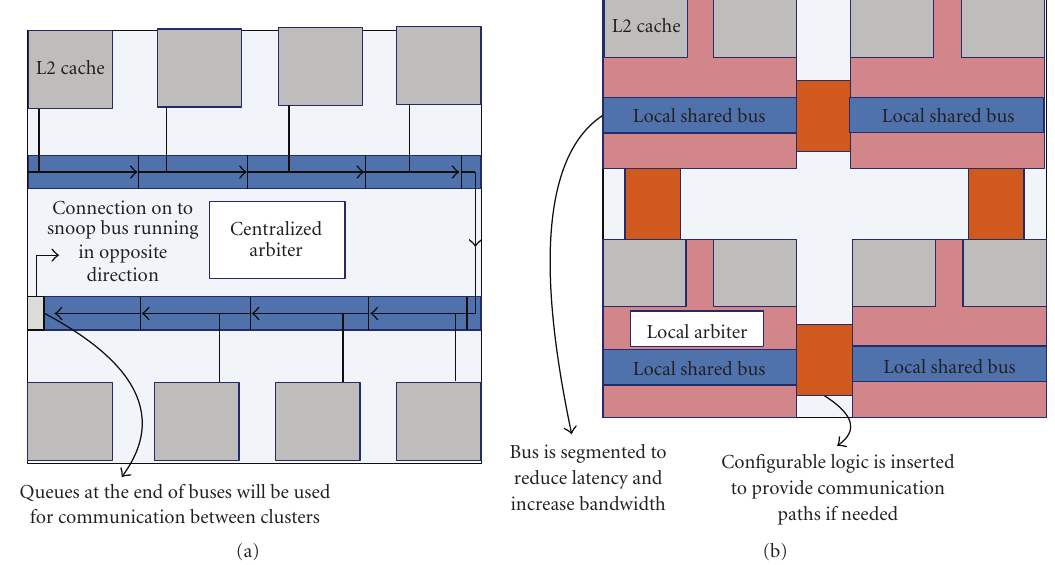
Figure 7: (a) Baseline multicore architecture versus; (b) Clustered multicore architecture.